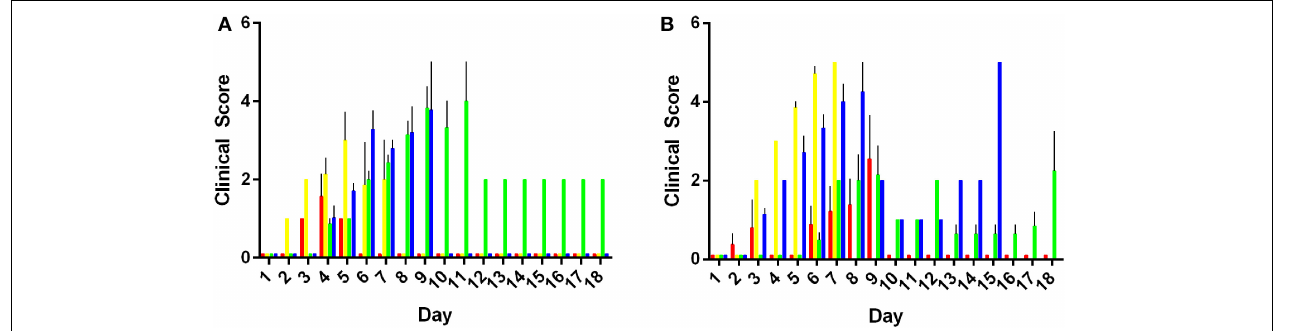
day 6 and 10 post infection. Morbidity was observed in animals inoculated with 10 5 CFU from day and peaked between days 5 and 9 post infection (p.i.) (B) . DT44 (red), DT135 (yellow), DT170 = 108 (green) and DT193 (blue).